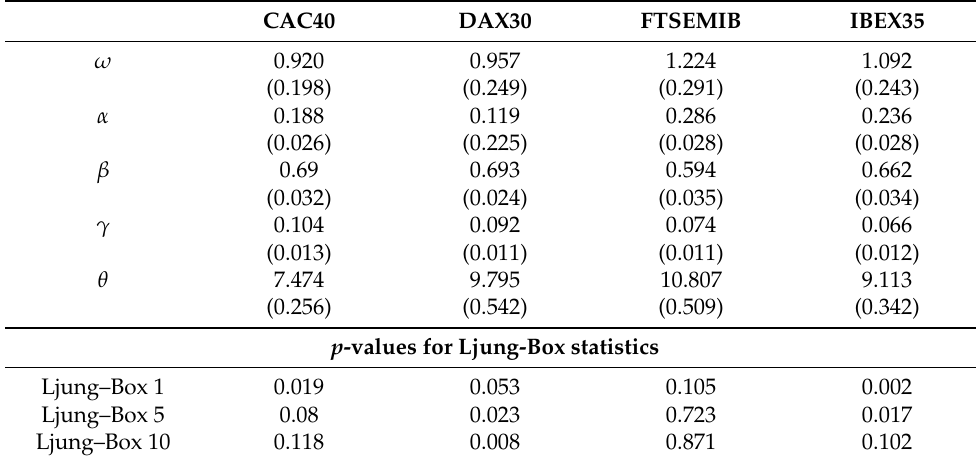
Table 2. Model Estimation results from the AMEM (robust s.e. in parenthesis) and p -values for the Ljung–Box statistics. Estimation period: 1 June 2009–31 December 2019. Dependent Variable: Realized